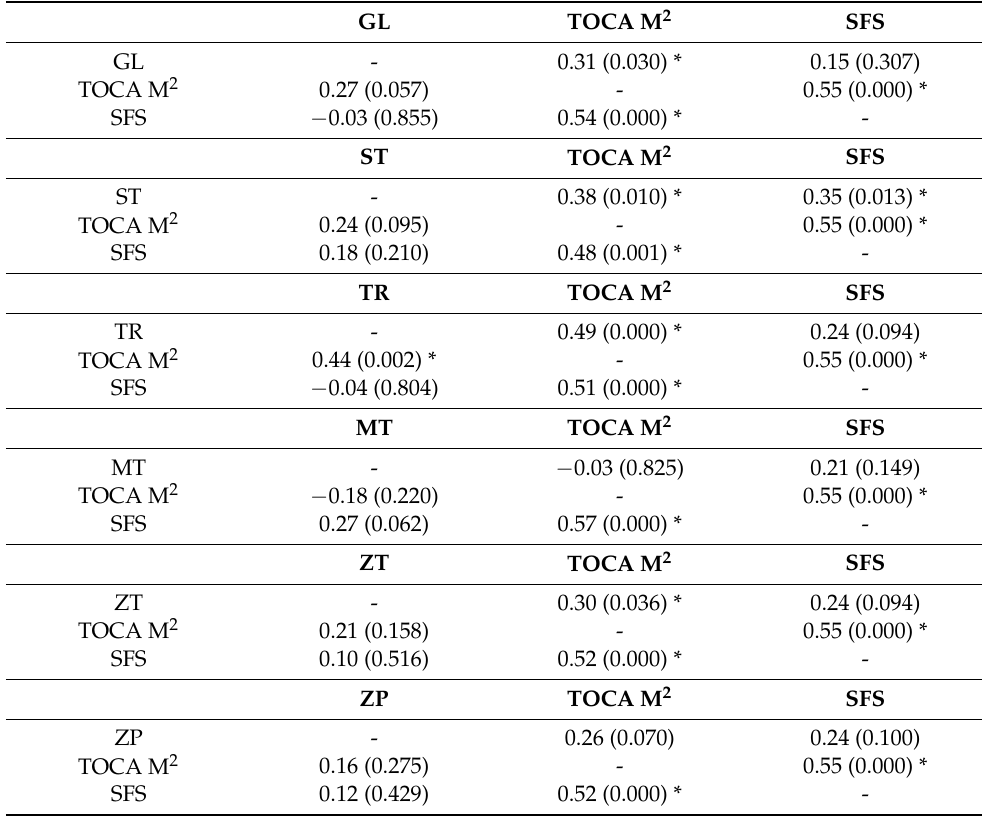
Table 9. Results of Spearman’s rank correlation analysis (top) and partial rank correlation analysis (bottom) obtained for examined traits including the TOCA of M 2 s—male cranial